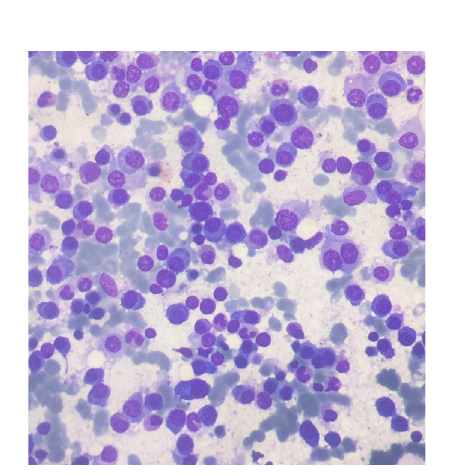
Figure 3. Bone marrow aspirations showing diffused plasma cell dyscrasia and diffuse infiltration of myeloma cells.